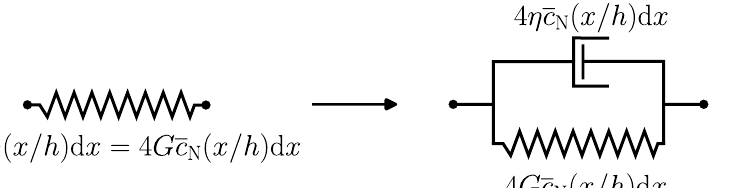
Figure 10. To model (incompressible) viscoelastic behavior, the independent springs of the one- dimensional MDR bedding are exchanged with rheological models (Kelvin–Voigt model in the